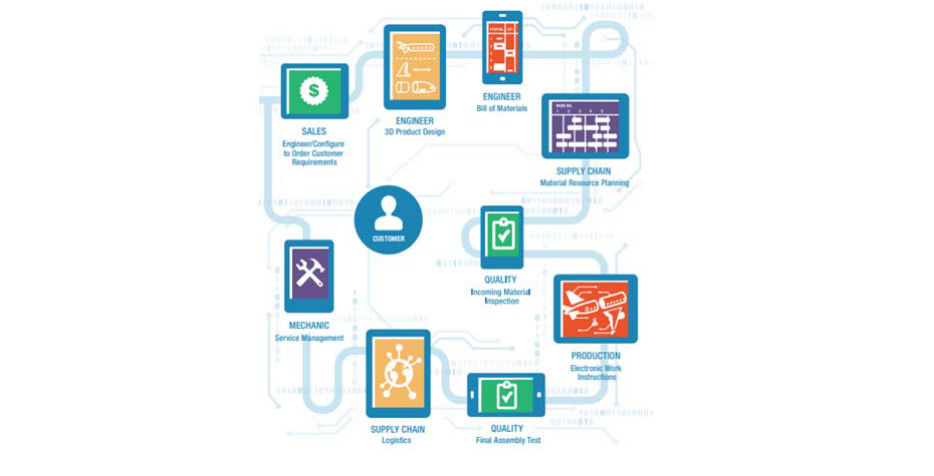
Figure 5. Loop diagram of a never-ending cycle of one’s product manufacturing